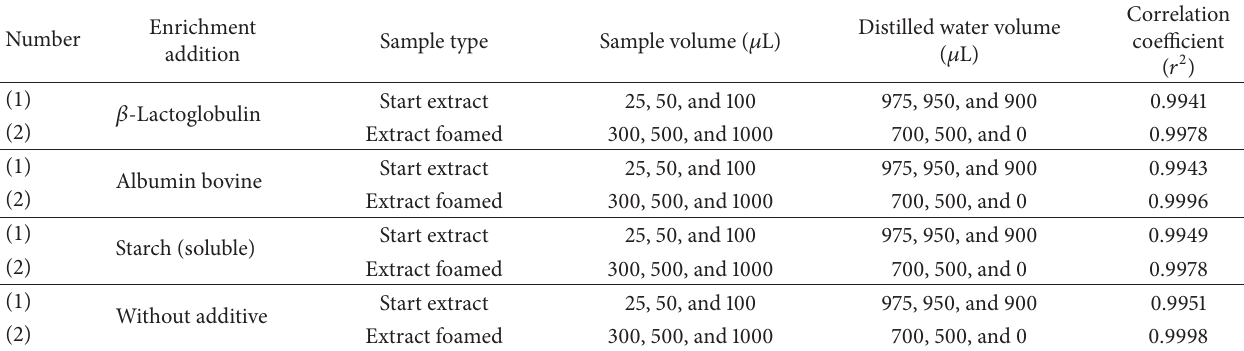
Table 2: Correlation coefficient, enrichment addition, type, and volume of all the sample types on HPLC.